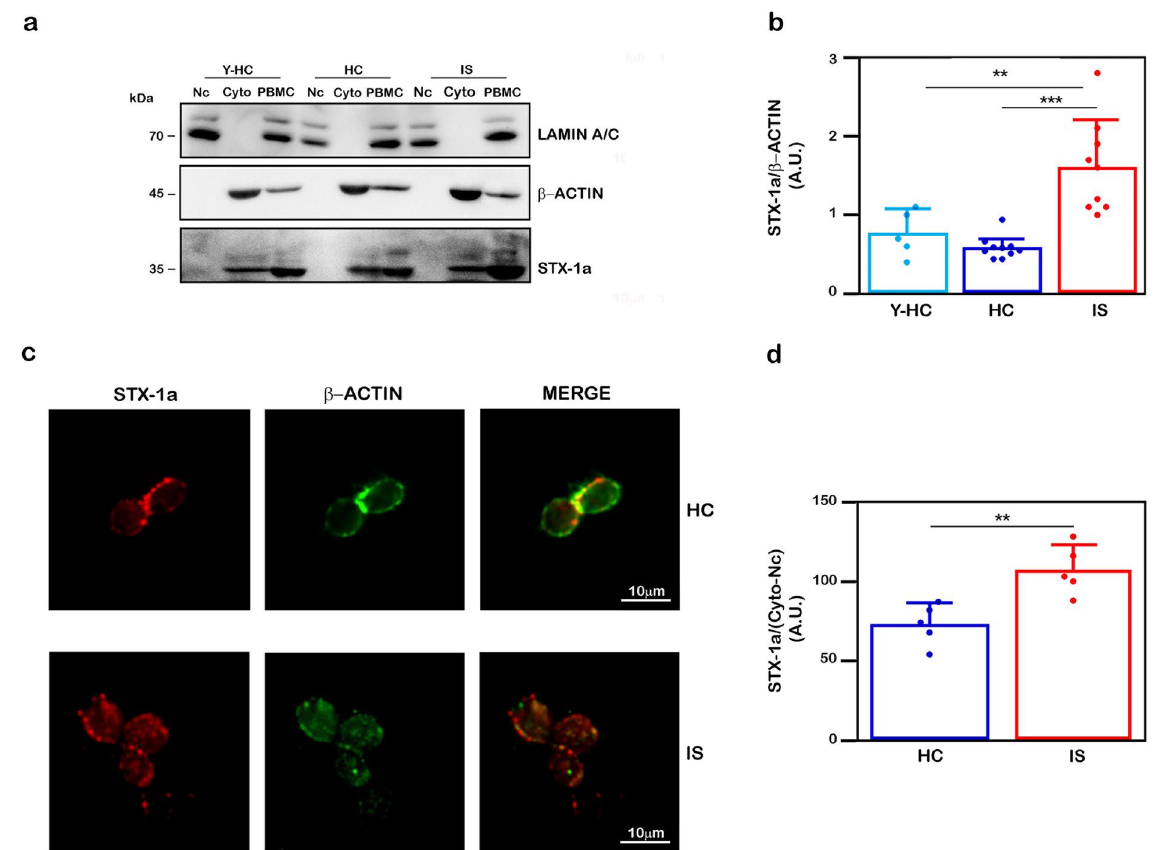
Figure 5. Confirmation of increased STX-1a levels in PBMCs of IS patients with respect to HC subjects. ( a ) Representative WB of STX-1a expression levels in PBMC cytoplasmic fractions. Representative WB analysis of cytoplasmic and nuclear fractions of PBMCs. For each sample, the STX-1a densitometric values have been normalized to that of β-actin. The successful separation of the nuclear (Nc) and the cytoplasmic fractions (Cyto) of PBMCs is demonstrated by the presence of the nuclear marker lamin A/C in the nuclear fraction and that of β-actin in the cytoplasmic one. ( b ) Quantitative analysis of cytoplasmic STX-1a. STX-1a expression levels have been analyzed by using One-way ANOVA with post-hoc Tukey test: STX-1a significantly increase in PBMCs of IS patients with respect to HC (p ≤ 0.0001) and Y-HC (p ≤ 0.003) subjects, while no difference is observed between the two control groups (p = 0.7). ( c ) Representative Immunofluorescence analysis of STX-1a in PBMCs of IS patients and HC subjects. PBMCs have been labeled with β-actin (green) and STX-1a (red). The STX-1a fluorescence intensity has been normalized by dividing the measure of its intensity by that of the β-actin subtracted from that measured for the nucleus (DAPI immunostaining). ( d ) Quantitative analysis STX-1a levels in PBMCs. The normalized STX-1a expression levels have been analyzed by using One-way ANOVA with post- hoc Tukey test: STX-1a levels are significantly increased in PBMCs of IS patients with respect to HC subjects (p = 0.005). Original magnification: 60X. Bars correspond to 10 µm. For WB analysis 4 µL of each fraction (Nc and Cyto) and 100 µg of whole PBMCs have been loaded in each lane. For IF analysis at least 15 cells for each subject have been analyzed. In quantitative graphs (panels b and d ) each point in a frame depicts the value for a single subject (n = 5–10 IS patients, 5–10 HC subjects and 0–5 young HC subjects, respectively in ( b ) and ( d ) while bars represent the median value ± SD. **p ≤ 0.005; ***p ≤ 0.001. Uncropped WB in a) have been reported in Fig. S8